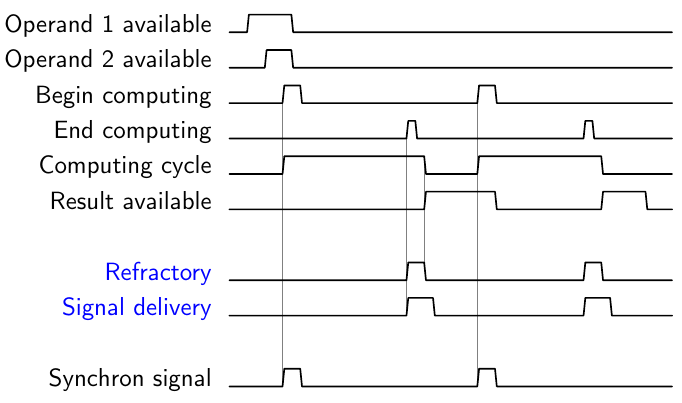
Figure 1. Timing relations of von Neumann’s simplified (incomplete) timing model: the data transfer time neglected apart from the data processing time; synchronization can have small